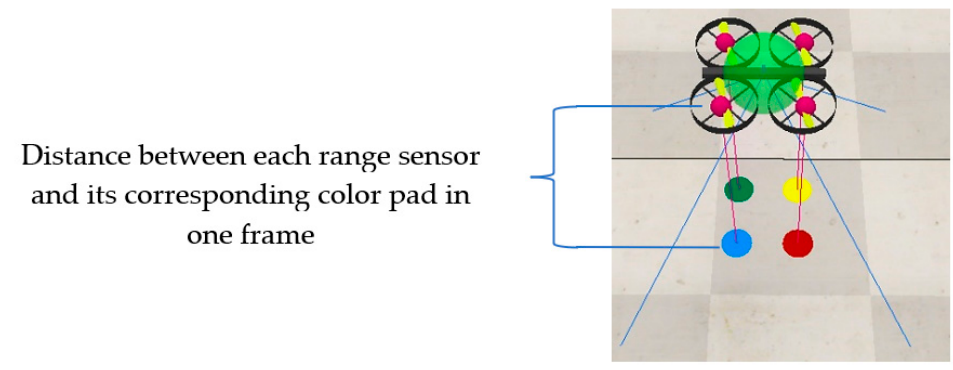
Figure 4. Camera range calibration procedures in each stage.